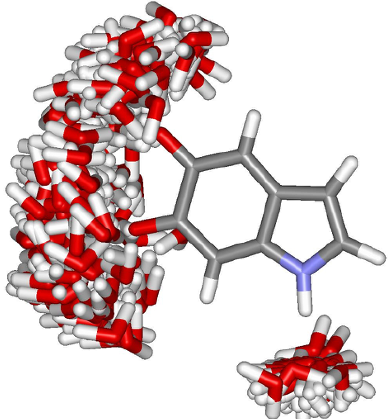
Figure 4. Hydrogen bond configuration space obtained for IQ in aqueous solution. The figure corresponds to the superposition of 100 statistically uncorrelated configurations obtained from classical Monte Carlo simulations. Oxygen (red), hydrogen (white), nitrogen (blue) and carbon